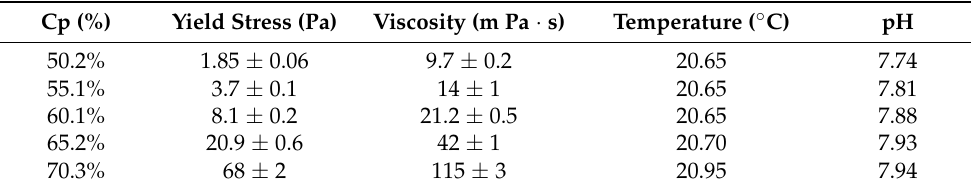
Table 5. Results of rheological tests on the tailing used.